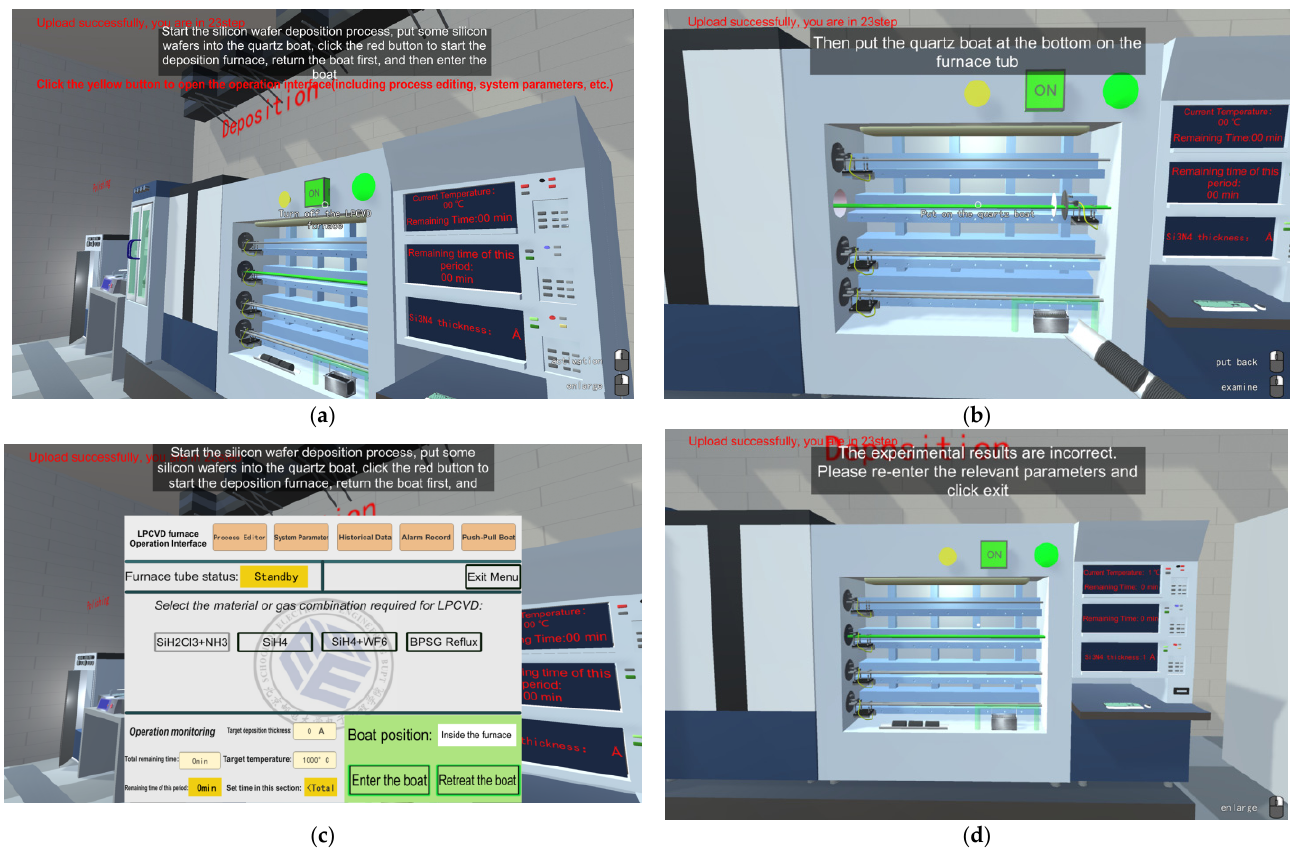
Figure 11. CVD device operation. ( a ) Turn on the CVD device switch; ( b ) Put the quartz boat on the furnace tube; ( c ) CVD device control page; ( d ) If the experimental results are incorrect, it will indicate that the experiment has